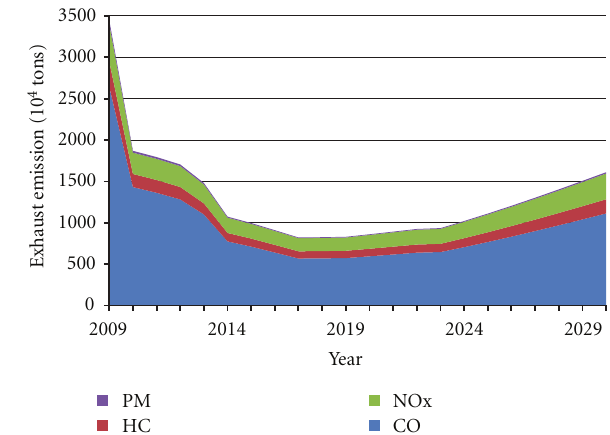
Figure 6: Forecast curve of China’s exhaust emissions in Scenario A.